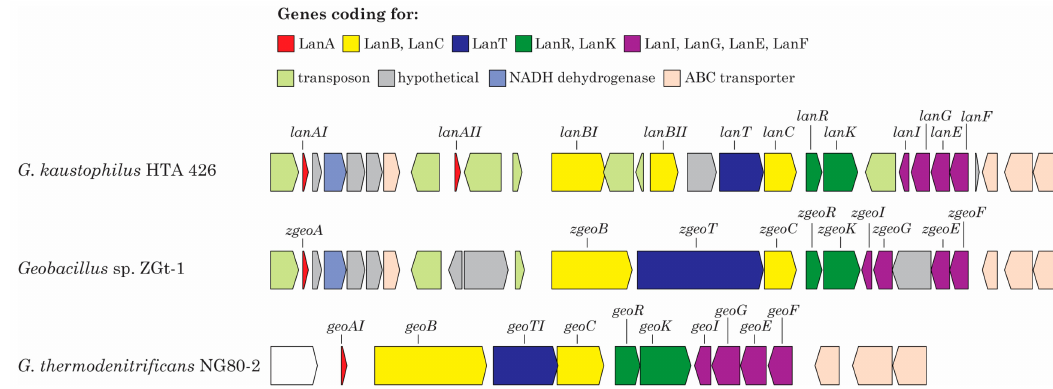
Figure 3. Class-I lanthipeptide clusters of three Geobacillus strains, G. kaustophilus HTA426, Geobacillus sp. ZGt-1, and G. thermodenitrificans NG80-2. The illustrated clusters were drawn after the lanthipeptide